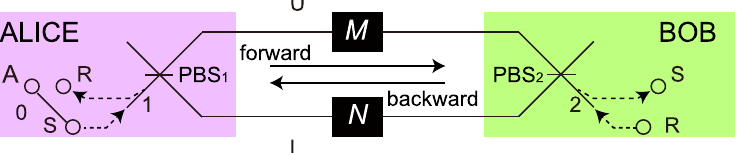
Figure 1. Entanglement distribution protocol by using a counter-propagating photon as a reference light 20 . When photons S and R are reached at port 2 and 1, respectively, the entangled photon pair between Alice and Bob is extracted by the quantum parity check on photons A and